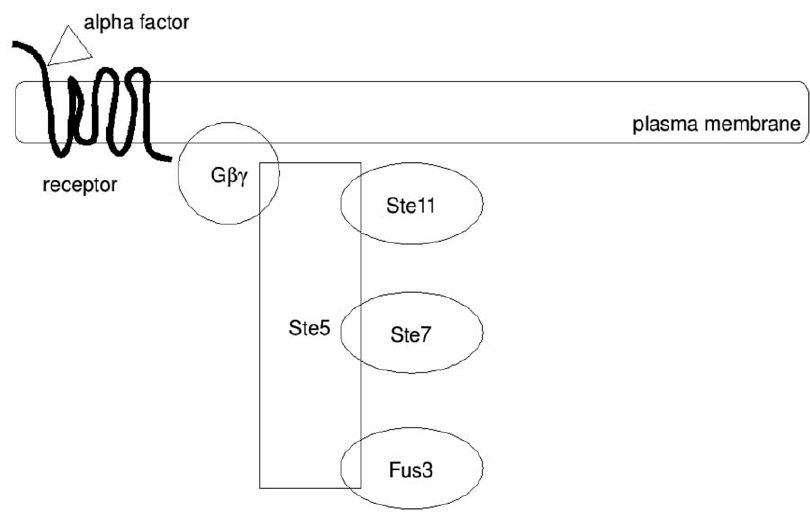
Figure 2. Cartoon representation of the yeast scaffold-MAPK signaling complex.